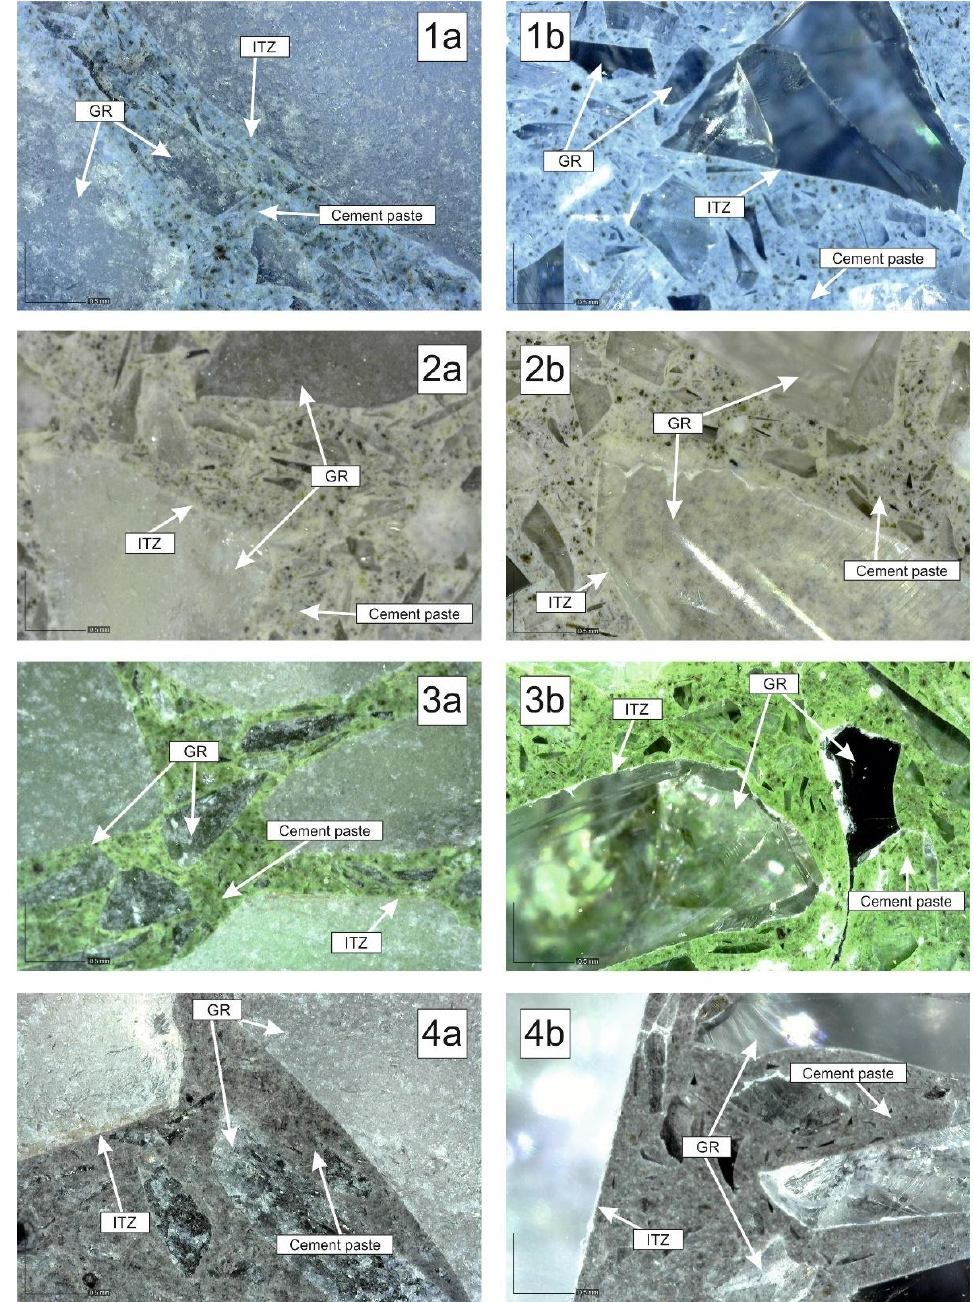
Figure 16. Structure of cement composites based on recycled glass with added pigment; ( a )—unpol- ished composite; ( b )—polished composite; 102× magnified. ( a )—unpolished composite; ( b )—polished composite; 102 ×